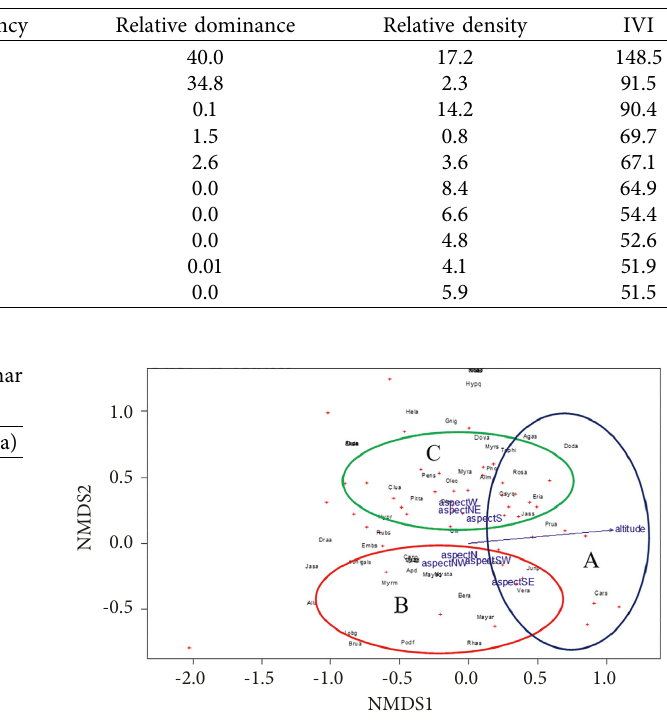
Figure 5: NMDS plot showing species related to altitudinal var- iation and topographic aspects . In both axes, cluster A shows species that are positively correlated with altitude; in the first axis, cluster B shows species that are positively correlated with topo- graphic aspects (N, NW, SW, and SE); in the second axis, cluster C shows species that are positively correlated with topographic as- pects (W, NE, and S). Abbreviated species’ scientific names were described in (Table